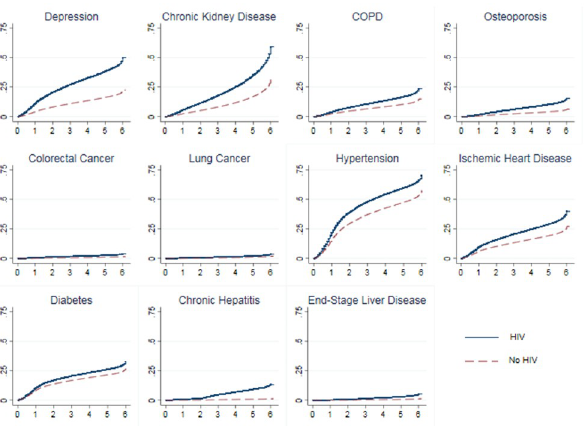
Fig 2. Cumulative incidence functions by HIV status. The y-axis is probability of diagnosis of each comorbidity and the x-axis is years since age 65.